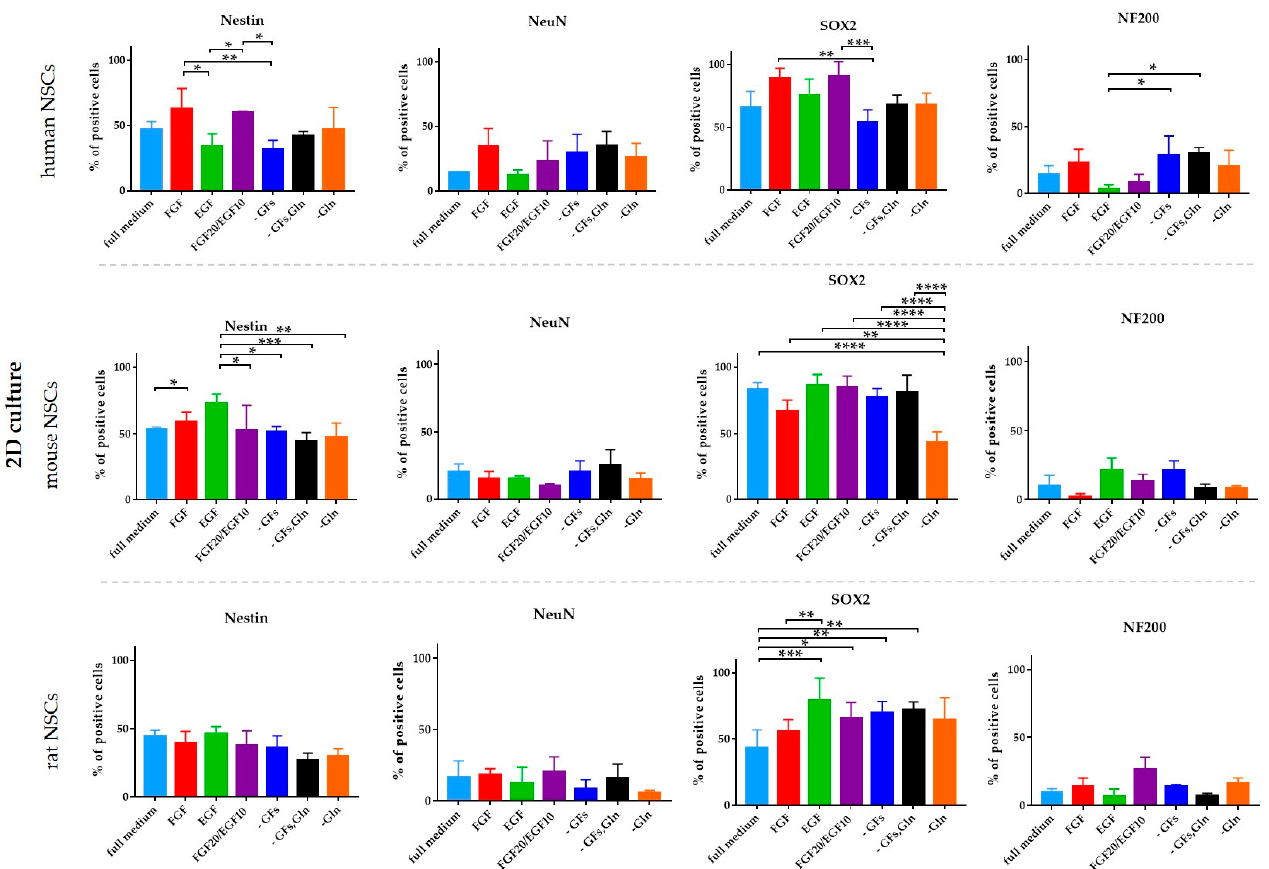
Figure 11. Neural differentiation of human, mouse, and rat NSCs cultured in 2D conditions. Quantitative analysis of neural (Nestin, SOX2) and neuronal (NeuN, NF200) markers. Cell culture conditions: 5% O 2 , 5% CO 2 , 37 °C. The results are presented as mean values of three experiments ± SEM. The differences were considered statistically significant when the p -value < 0.05. Statistical significance level: * for 0.01 < p < 0.05, ** for 0.001 < p < 0.01, *** for 0.0001 < p < 0.001, and **** for p < 0.0001.